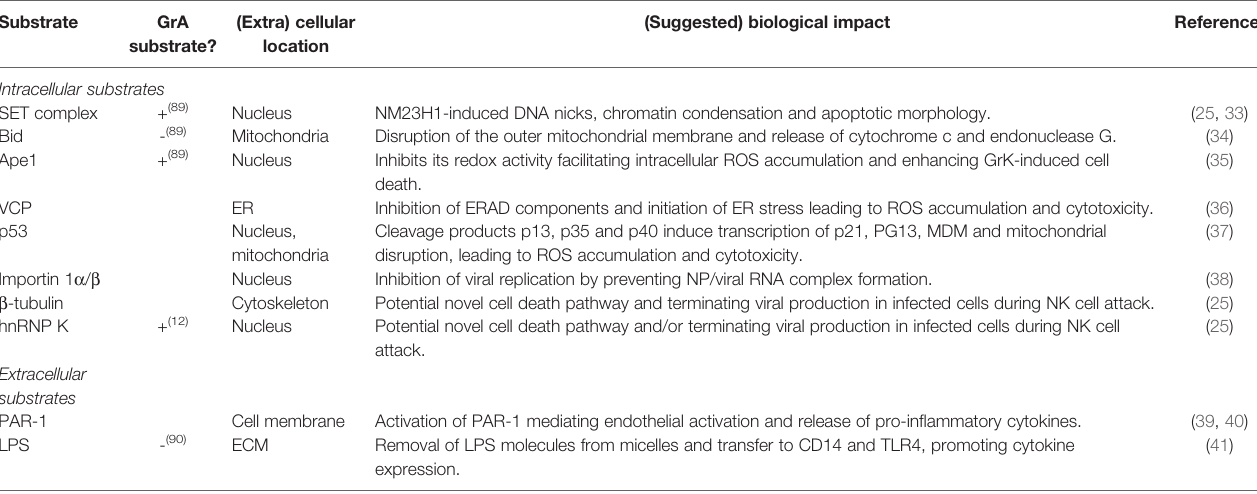
(Suggested) biological impact Reference